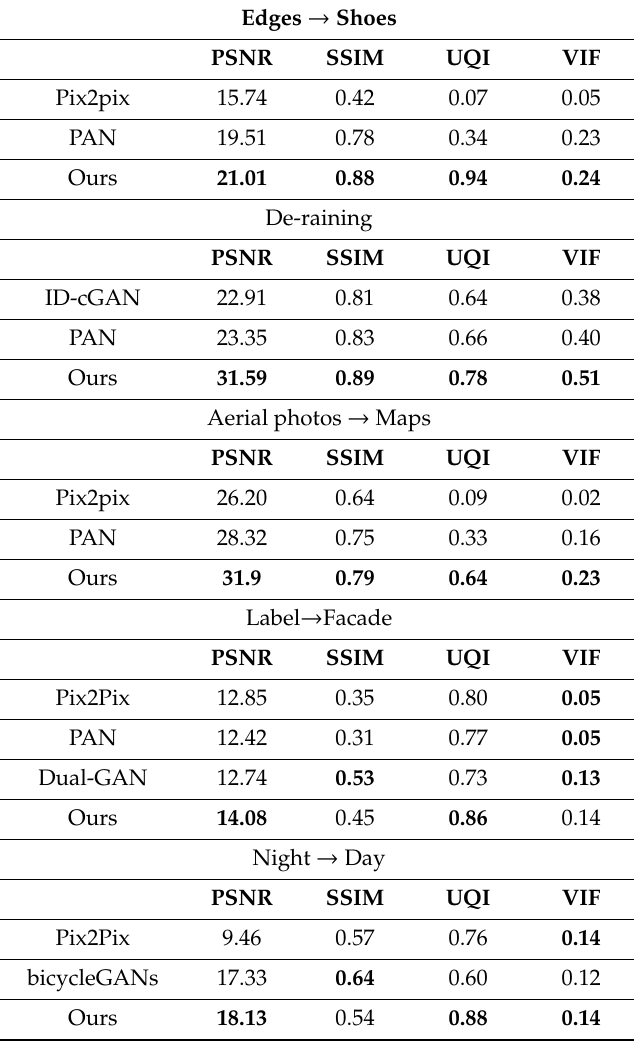
Table 3. Comparison with Existing